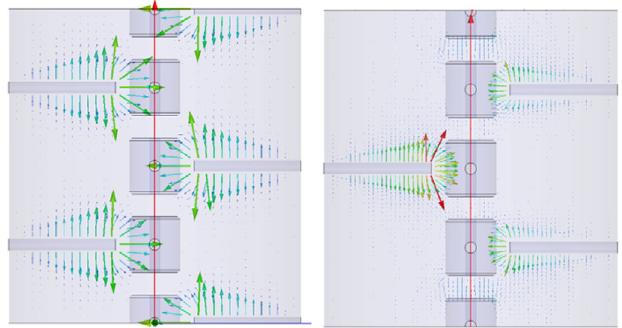
FIG. 3. The PC 0 mode can be simulated only with perfect magnetic end walls (left). With metallic end walls (right) it is not possible to excite a ‘‘pure’’ PC 0 mode.